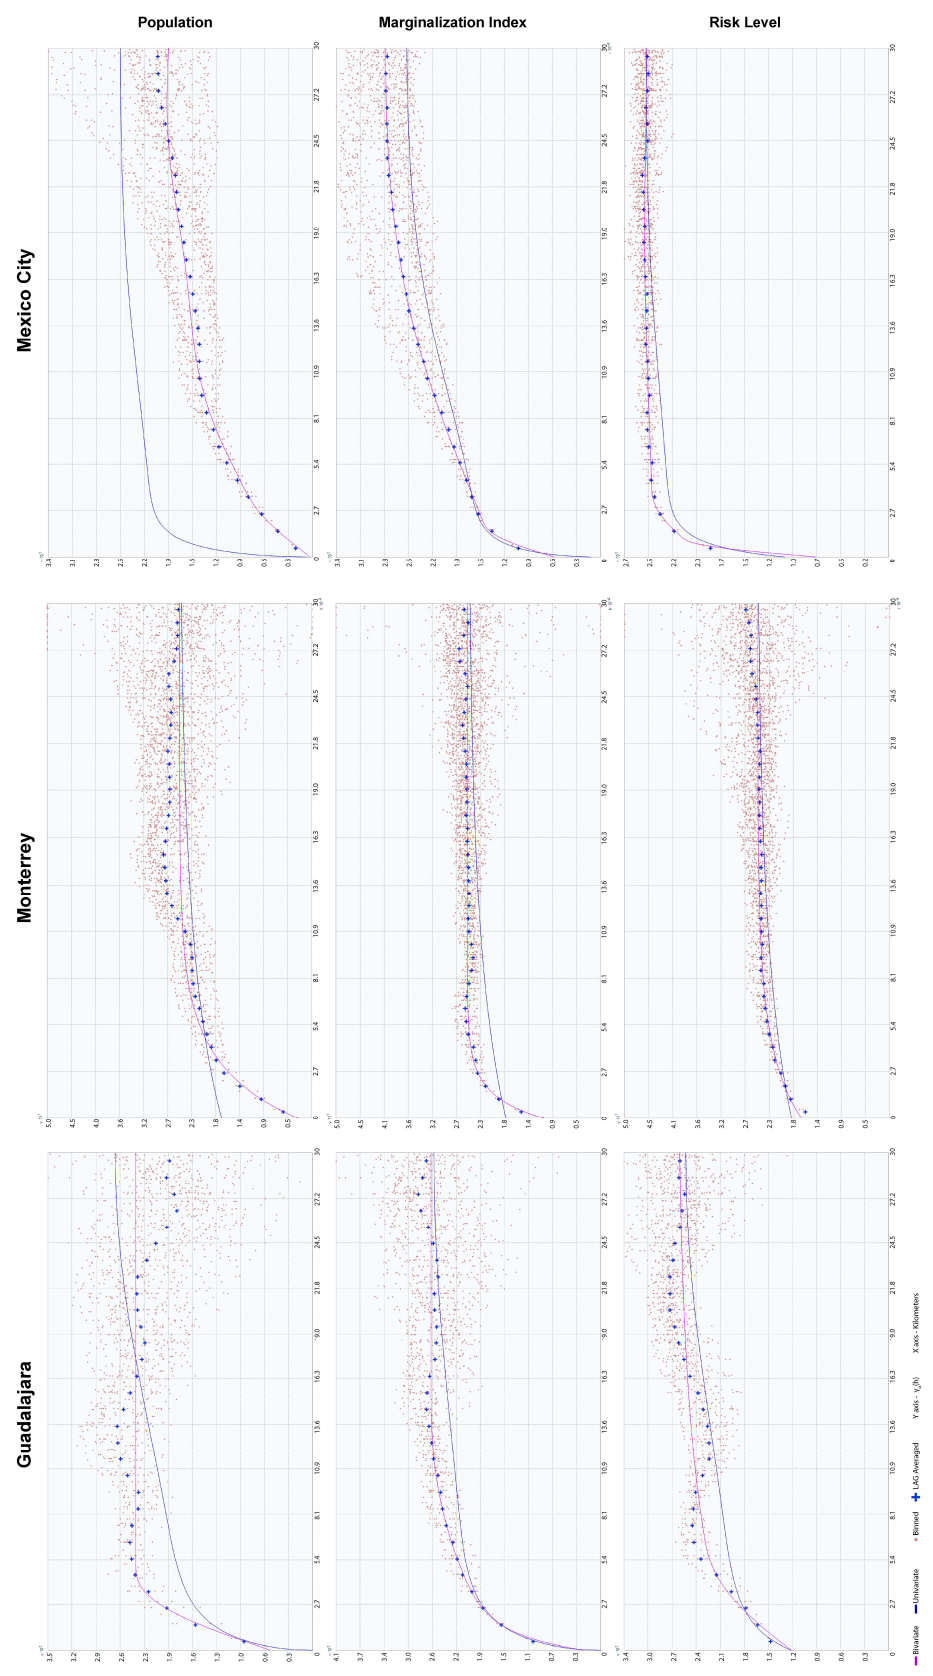
Figure 4. Semivariograms of each city and